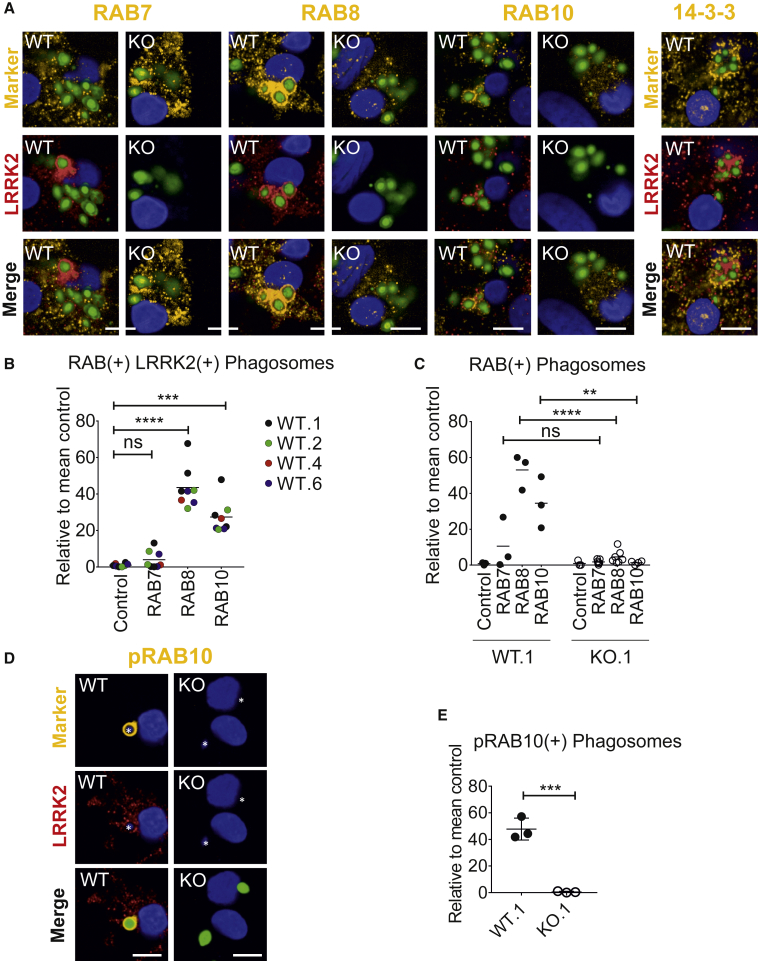
RAB8 and RAB10 Are Recruited to Phagosomes, and This Is LRRK2 Dependent(A) Confocal images of LRRK2 WT and LRRK2 KO hiPSC macrophages fed with zymosan Alexa Fluor 488 for 2 h, then fixed and stained for LRRK2 (Alexa Fluor 647, red) and RABs (RAB10 D36C4) or pan-14-3-3 protein (Alexa Fluor 546, yellow). Scale bars represent 10 μm.(B) Quantification of number of LRRK2+ phagosomes that are also RAB+. Data from four WT hiPSC macrophage lines (WT.1, WT.2, WT.4, WT.6); each data point represents the mean of 20 fields per independent replicate. Control, secondary antibody only.(C) Quantification of RAB+ phagosomes; each data point represents the mean of 20 fields per independent replicate.(D) Images as in (A) but stained for phosphoT73 RAB10 (Ab230261).(E) Quantification of (D), each data point represents the mean of 20 fields per independent replicate, overall mean ± SD.One-way ANOVA with Tukey's multiple comparison was performed for all statistical analyses, ∗∗p < 0.01, ∗∗∗p < 0.001, ∗∗∗∗p < 0.0001, not significant, ns: p > 0.05.